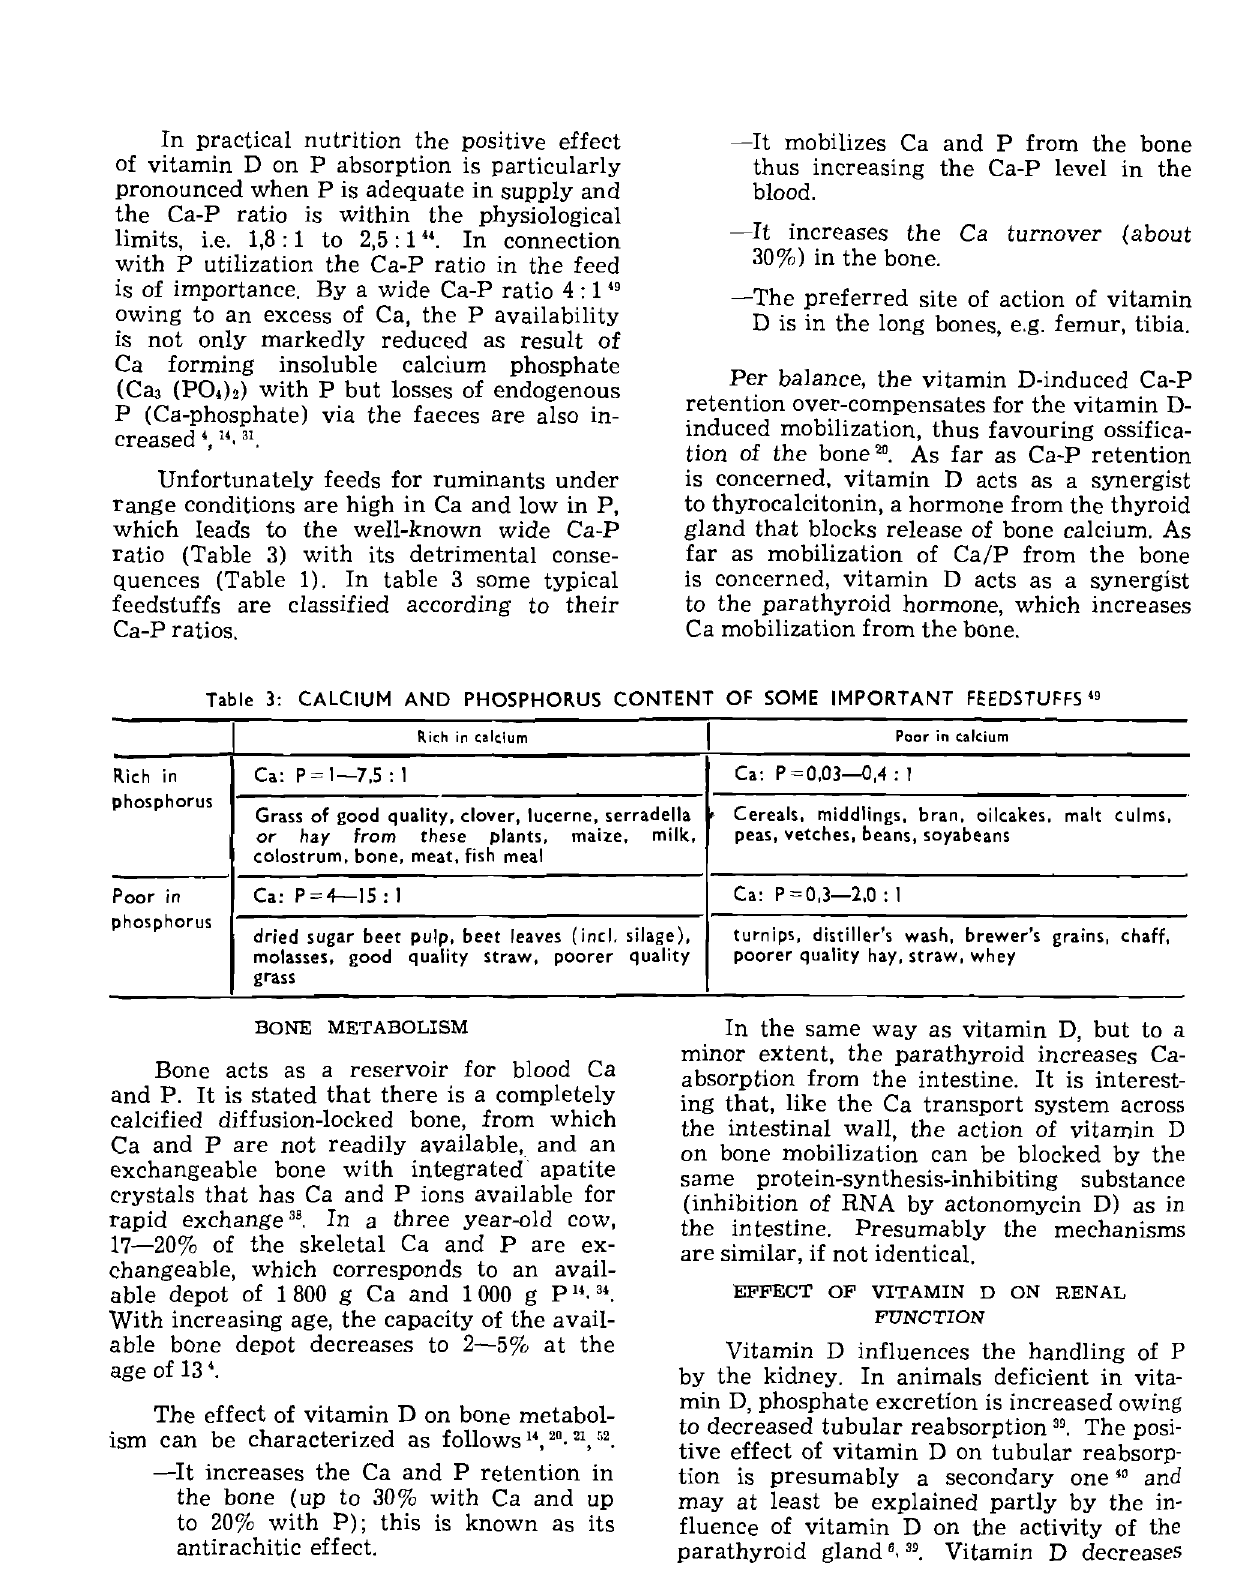
Table 3: CALCIUM AND PHOSPHORUS CONTENT OF SOME IMPORTANT FEEDSTUFFS '9 R.ich in